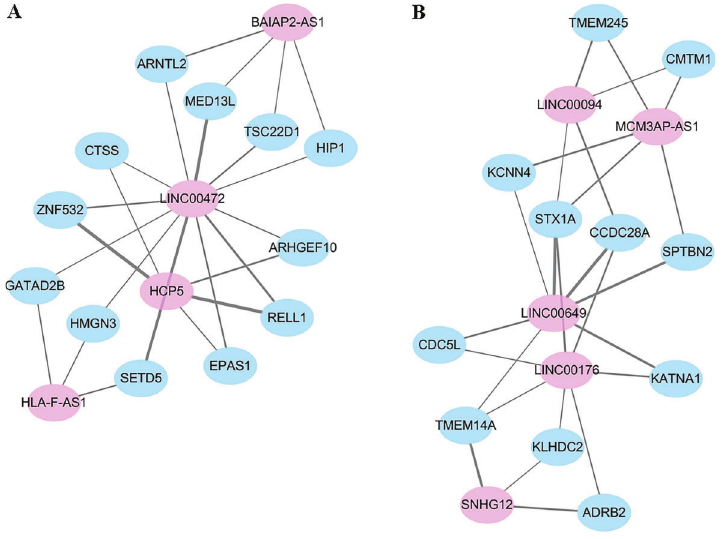
Figure 6. Extraction of synergistic, competing modules. A , Module 1. B , Module 2. Pink nodes denote lncRNAs, and blue nodes denote mRNAs.